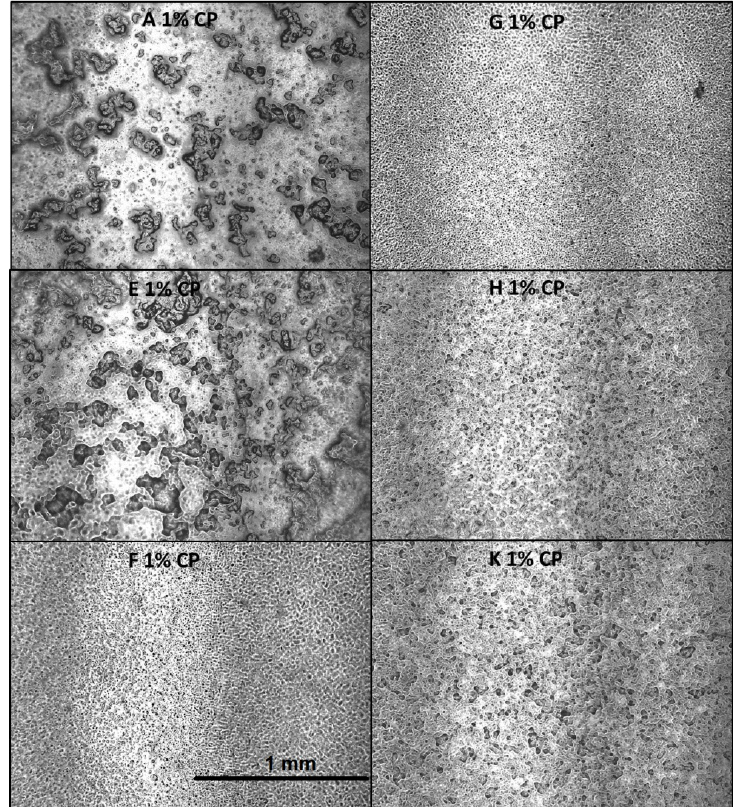
Figure 5. Micrographs of film Formulations A through K containing 1.0 wt% CP equilibrated at ~60% RH, with 4×